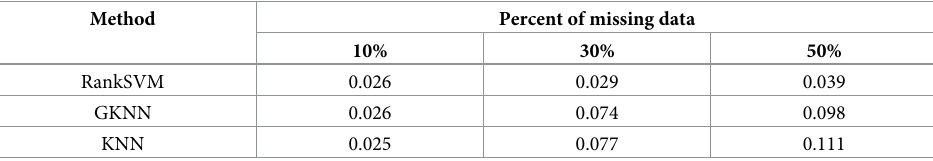
Table 4. Recovering error rates when different proportions of gallery data are